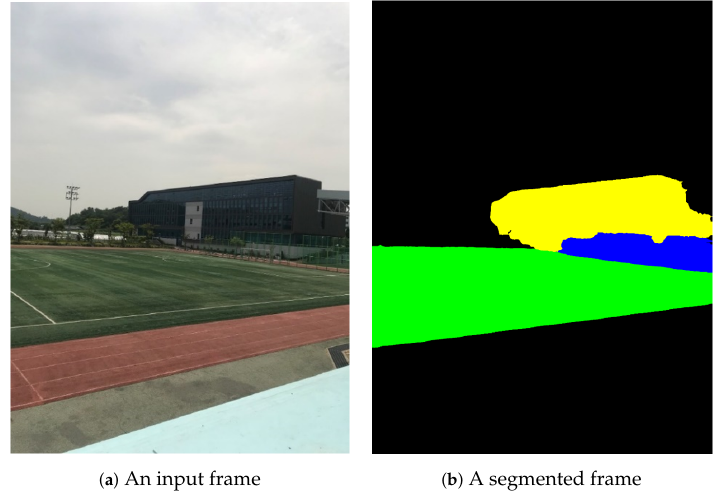
Figure 6. Example of semantic segmentation: green: ground ; black: other ; yellow: building ; blue: goalpost . Four video sequence pairs, seq1–4 , were shot at two sports stadiums for the perfor- mance evaluation of the proposed method. A static video camera pair installed with a separation of 1–2 m captured the inside of the stadiums from the stands. Each video se- quence pair consists of two video sequences captured using the left and right video cameras. There exists a maximum 70% overlap in the field of view in the left and right video frames in each video sequence pair. The resolution and the frame rate of each video sequence are 1920 × 1080 and 30 Hz, respectively. For a quantitative performance evaluation of stitched video frames, a center video sequence was shot simultaneously with the video sequence pair seq2 . The homography estimation interval N was set at 20